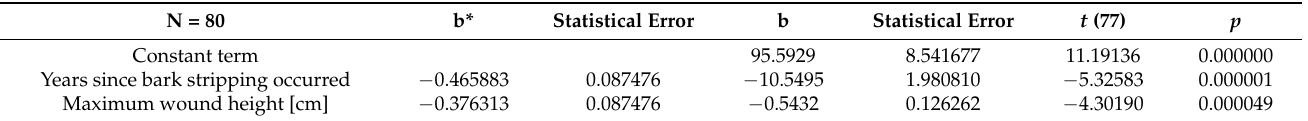
Table 7. Correlation coefficients of Sa/Ra index area, the years since bark stripping occurred variable, and the independent variable, maximum wound